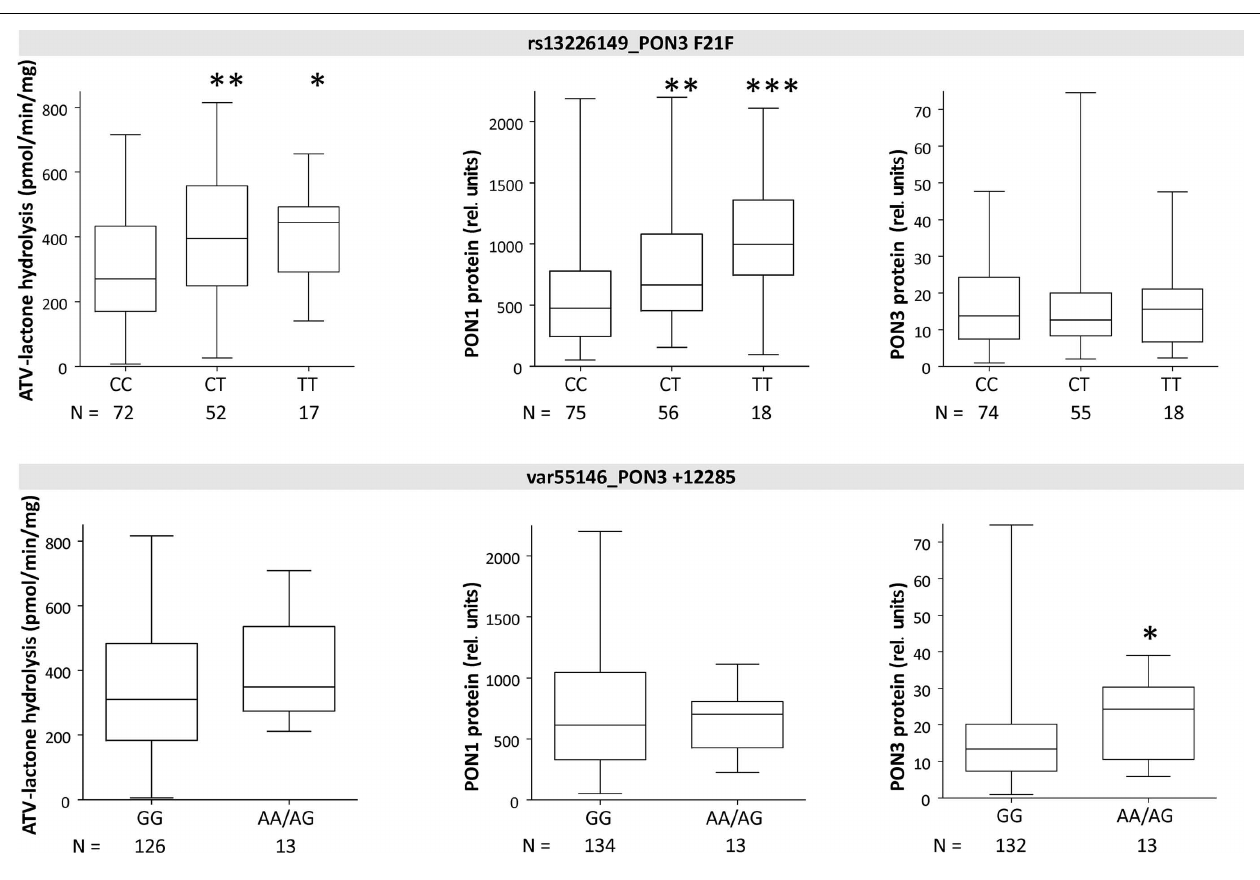
are compared with homozygotes of reference allele byWilcoxon–Mann– Whitney-tests significance levels are indicated for P < 0.05 (*), P < 0.01 (**), and P < 0.001 (***).